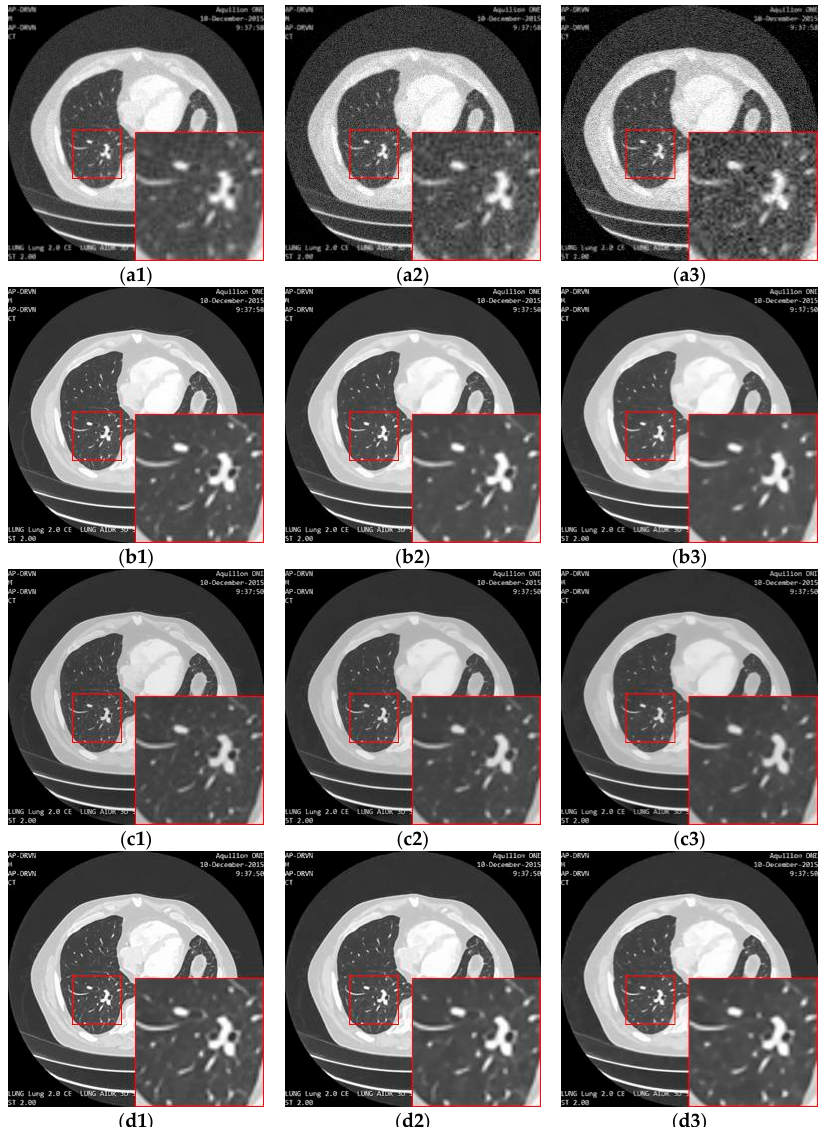
Figure 13. The result of enhancing the quality of images corrupted by noise with different levels and low-resolution through the proposed network with different loss strategies. ( a1 ), ( a2 ) and ( a3 ) are the input images with noise level 5, 10 and 15. ( b1 ), ( b2 ) and ( b3 ) are the ground truth images. ( c1 ), ( c2 ) and ( c3 ) are the images ( a1 ), ( a2 ) and ( a3 ) processed by the proposed network with MSE loss. ( d1 ), ( d2 ) and ( d3 ) are the images ( a1 ), ( a2 ) and ( a3 ) processed by the proposed network with the MSE-perceptual joint loss. Table 3. Quantitative results (mean ± std of PSNR and SSIM) associated with di ff erent combinations of losses of the proposed network for enhancing the qualities of the images with di ff erent noise levels. Noise